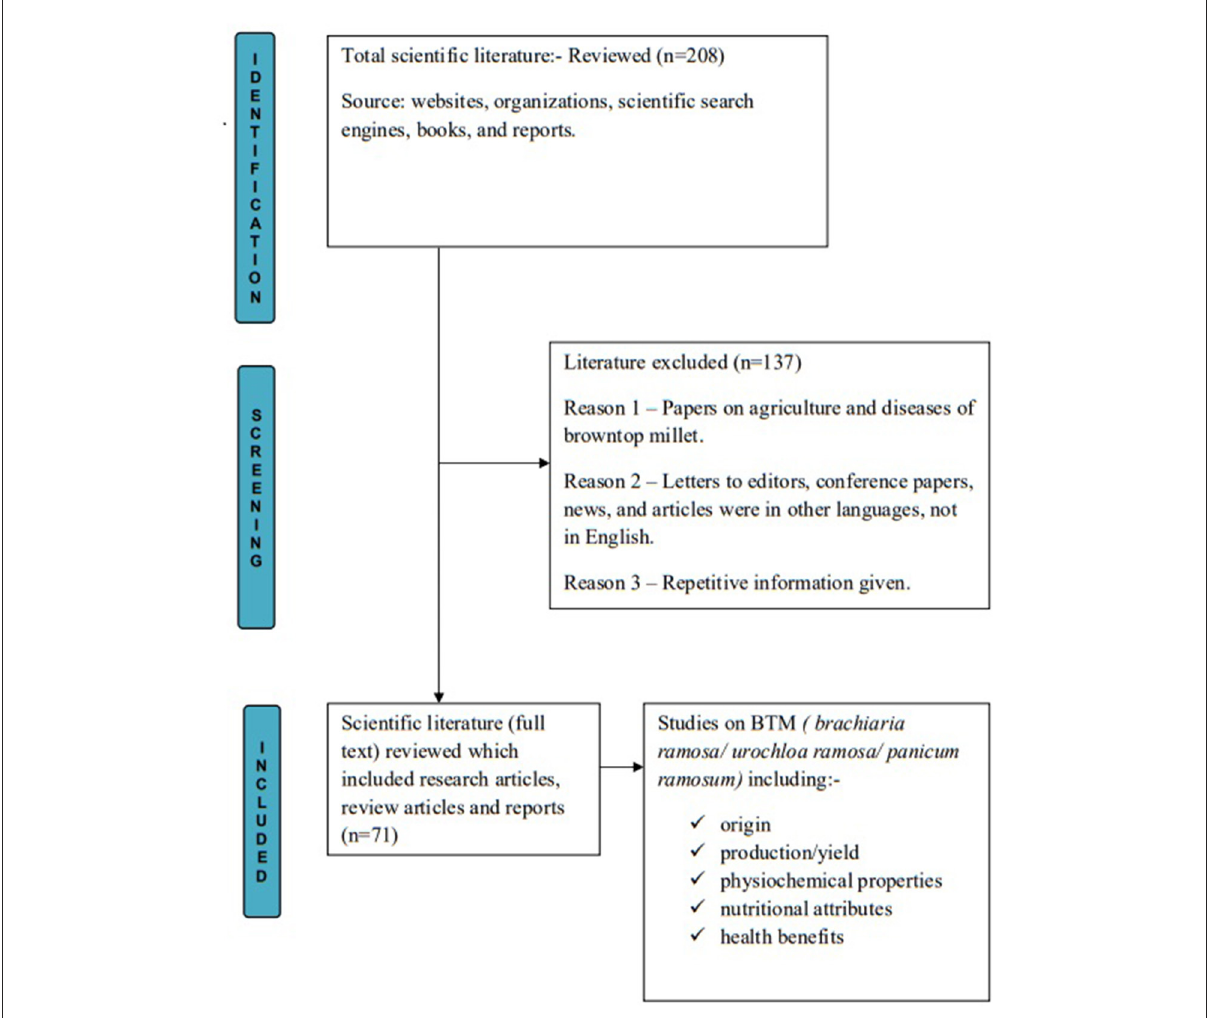
FIGURE1 Algorithm of method followed for selection of studies chosen for the